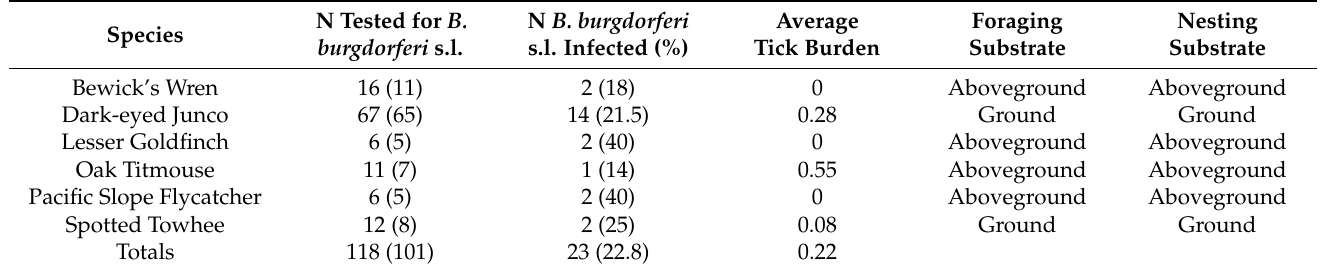
Table 1. Avian host community sampling distribution, Borrelia burgdorferi s.l. infection prevalence, foraging and nesting substrate by bird species included in analysis. N Tested for